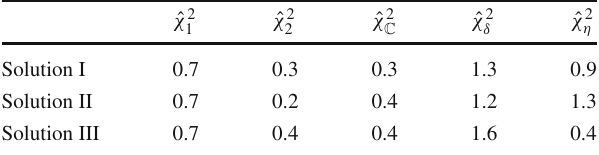
Table 7 Results in terms of ˆ χ 2 of the P-wave solutions I, II and III, in different regions